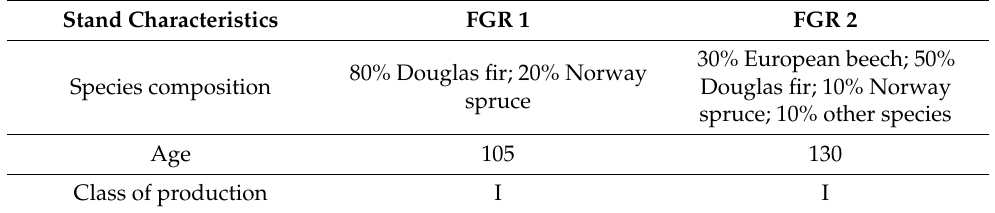
Table 1. The sites and stands characteristics of the Douglas fir forest genetic resources. Stand Characteristics FGR 1 FGR 2 30% European beech; 50% 80% Douglas fir; 20% Norway Species composition Douglas fir; 10% Norway spruce spruce; 10% other species Age 105 130 Class of production I